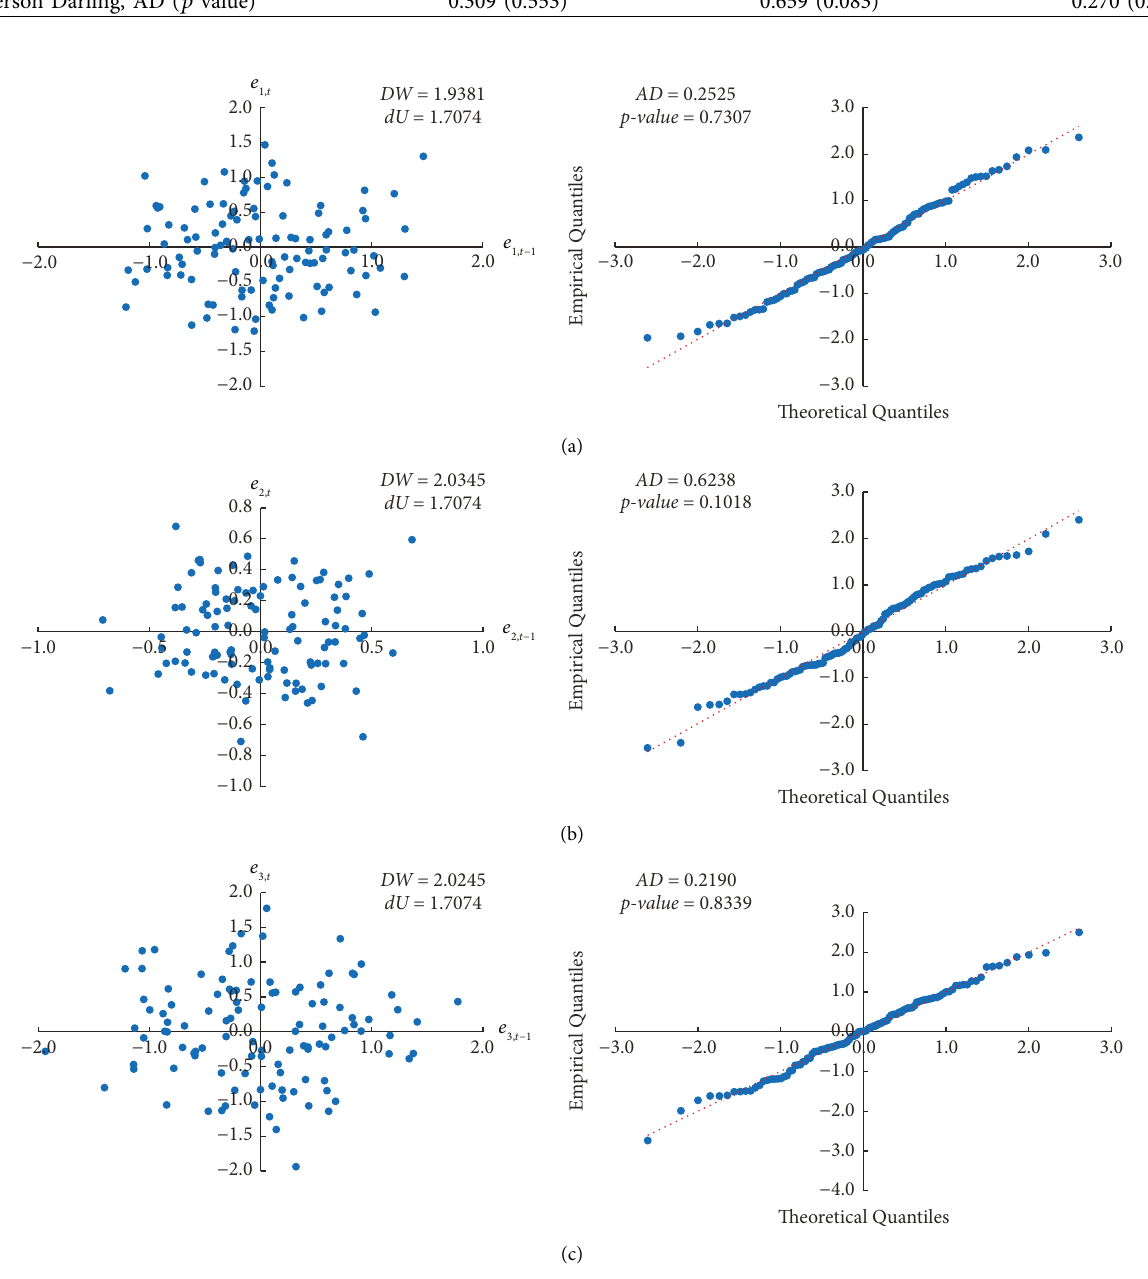
, (b) X , and (c) X . 1 2 3